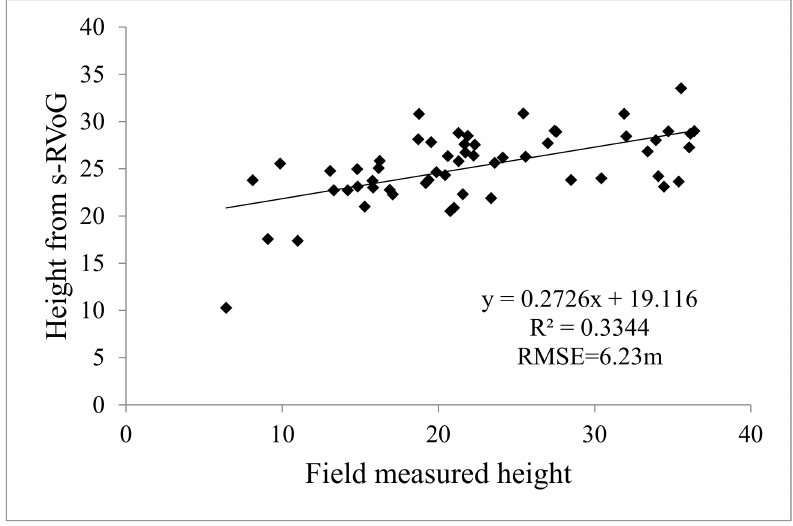
Figure 10. The scatter plots of s-RVoG estimation result considering all four decoherence and terrain